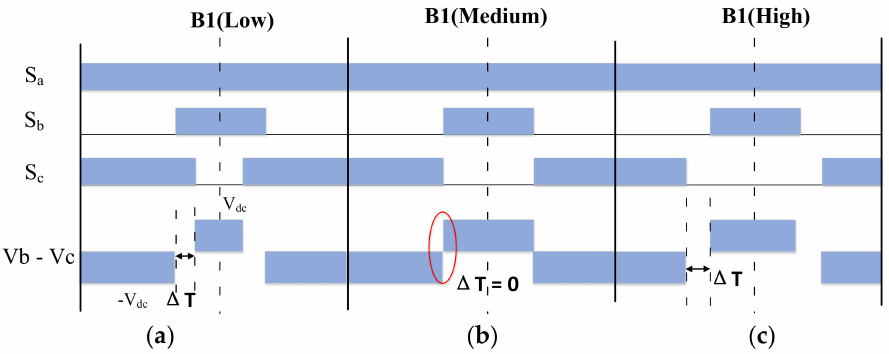
Figure 8. Zero-voltage time interval between line-to-line voltage pulse reversals in TSPWM in different regions: ( a ) low region; ( b ) medium region (modulation factor equals to 0.61); ( c ) high